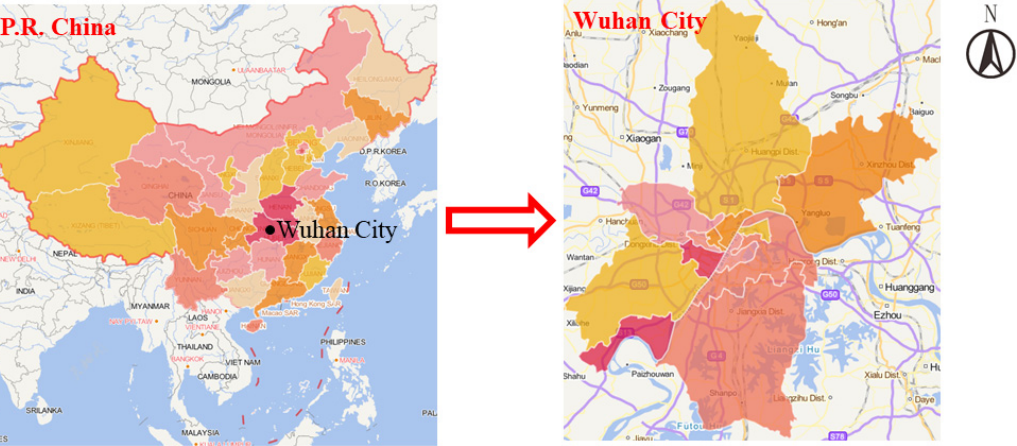
Figure 1. Selected research location (https://en.tianditu.gov.cn/ (accessed on 14 March 2021)).